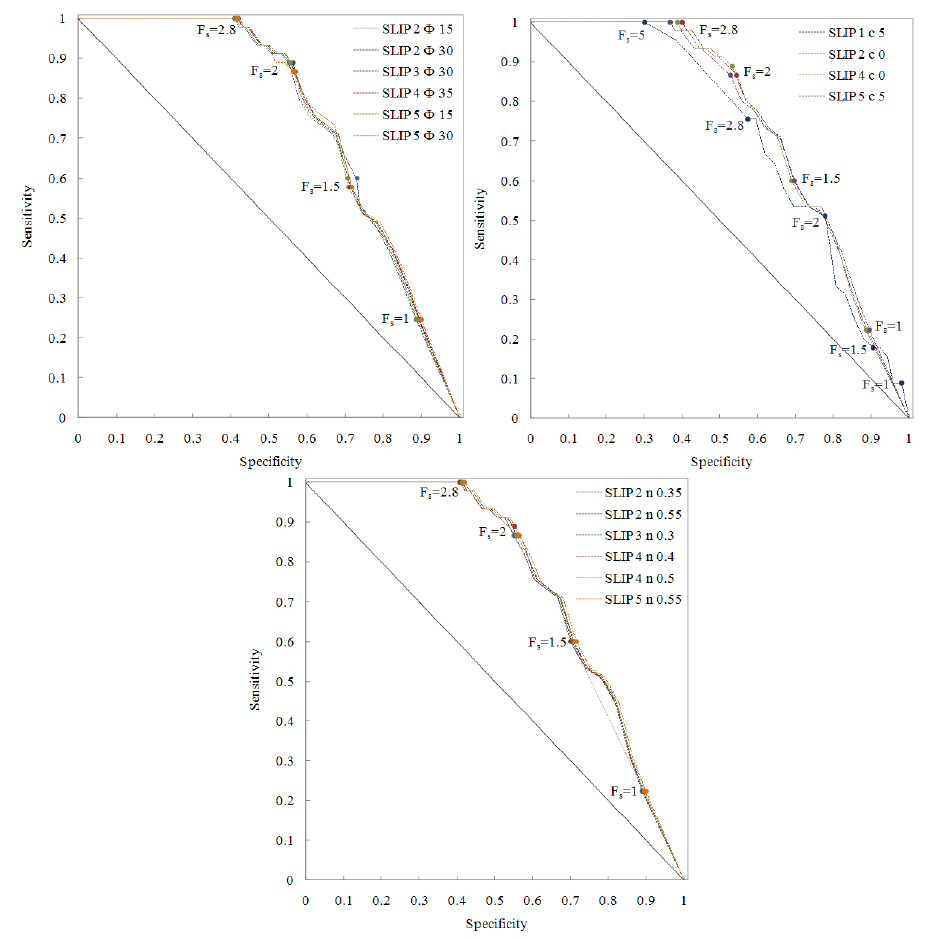
Figure 12c Fig. 12. ROC curves representing sensitivity analysis on soil parameters for the SLIP model (test-area, event of 11 April 2005): (a) results obtained for different values of φ 0 ; (b) results obtained for different values of c 0 ; (c) results obtained for different values of porosity ( n